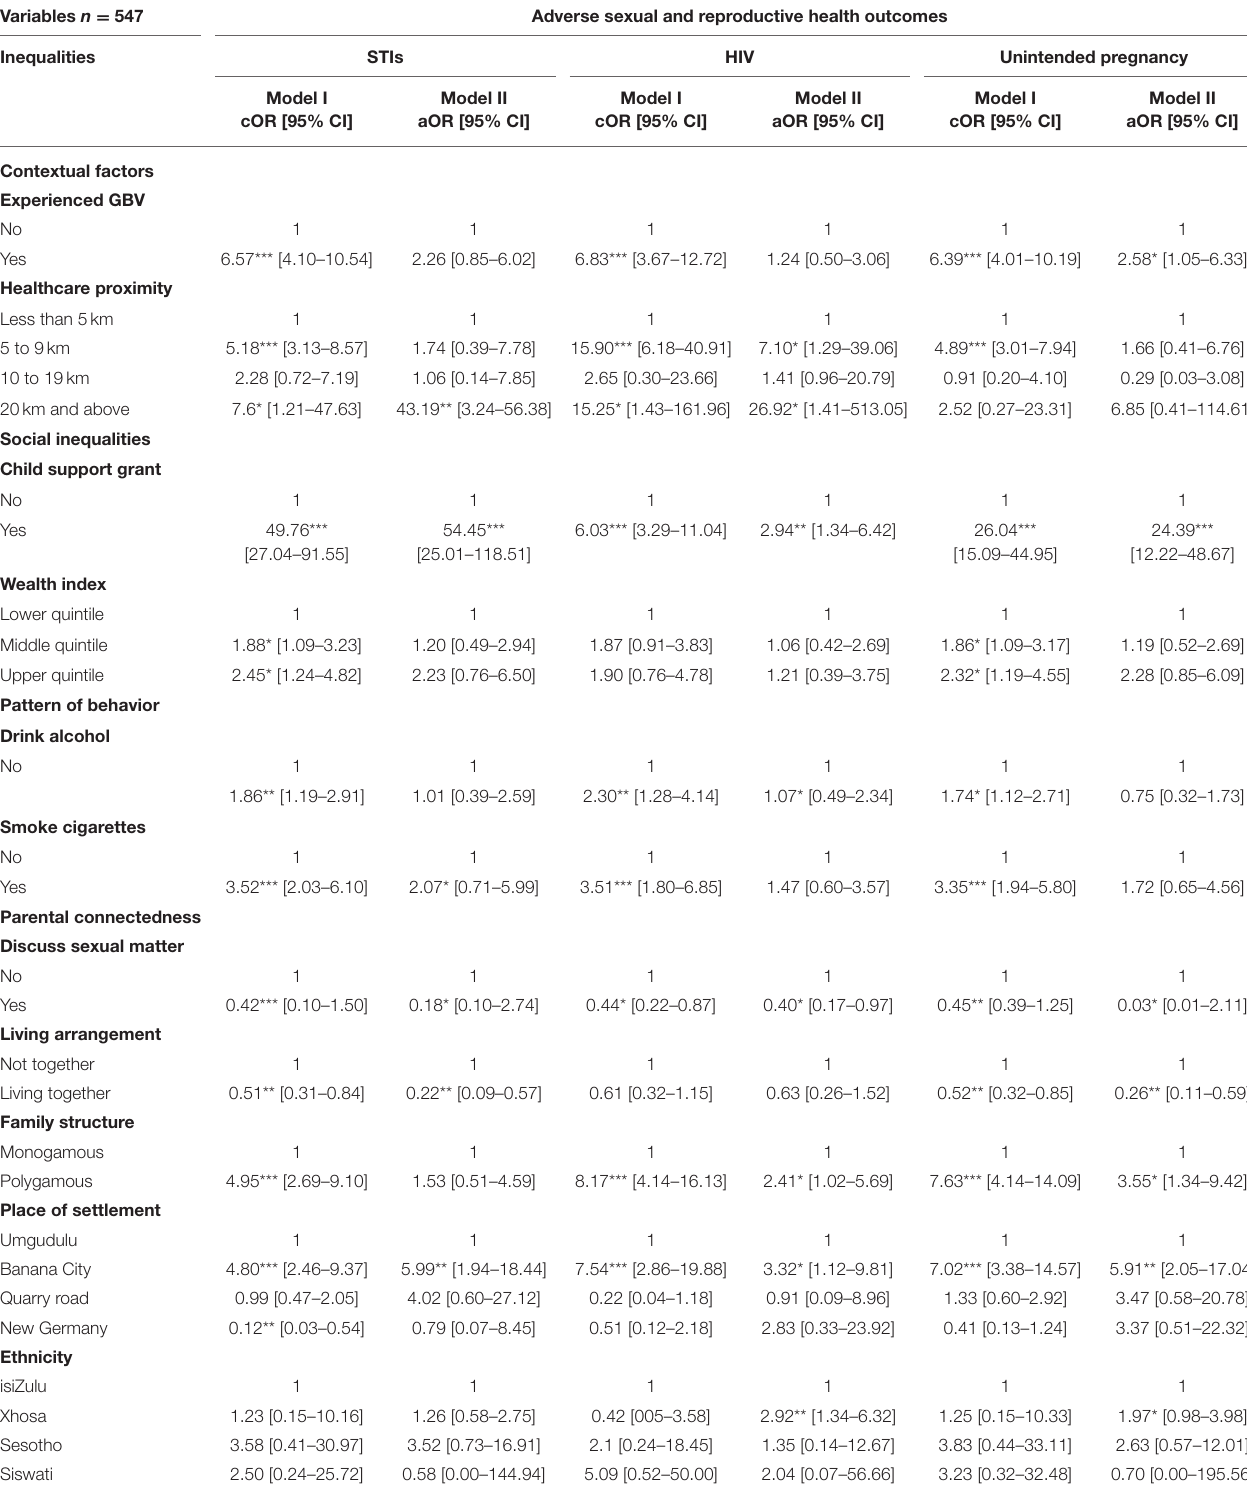
TABLE 2 | Binary and Multivariable logistic regression analysis of selected inequalities and adverse Sexual and Reproductive Health